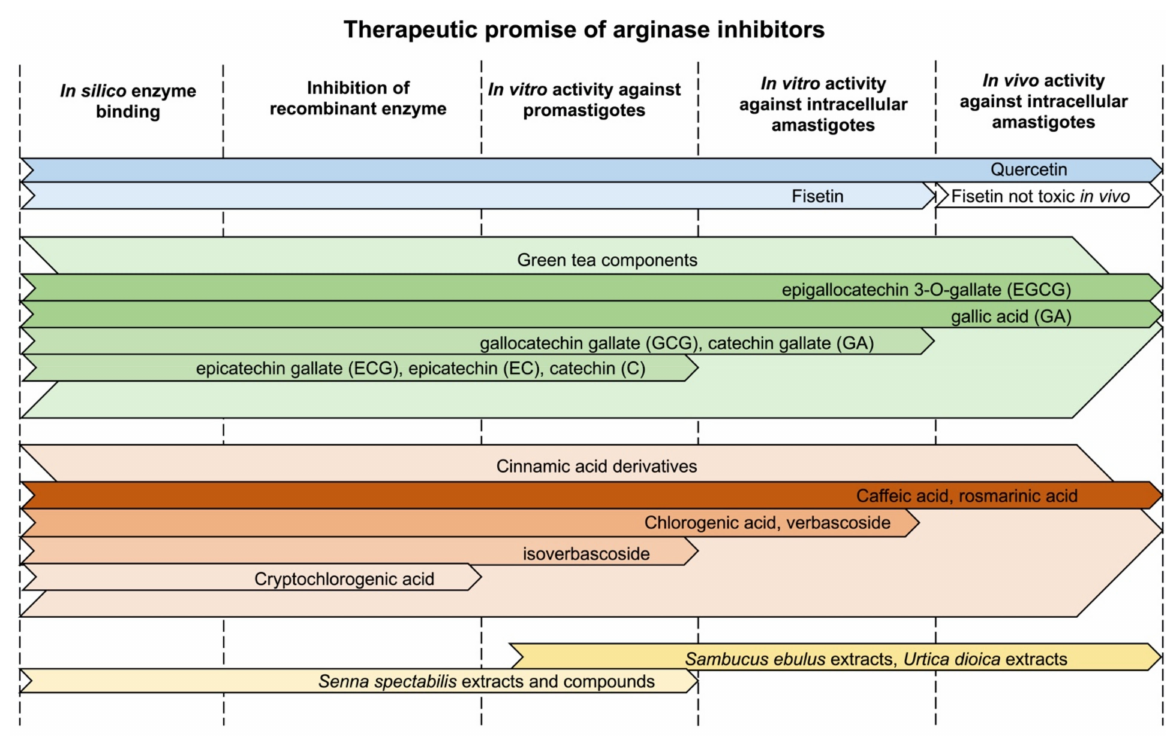
Figure 5. Therapeutic promise of arginase inhibitors. Colored arrows indicate if compounds have been tested in silico, were evaluated against the recombinant Leishmania arginase, exhibited toxicity towards promastigotes, demonstrated in vitro activity against intracellular amastigotes, or displayed in vivo